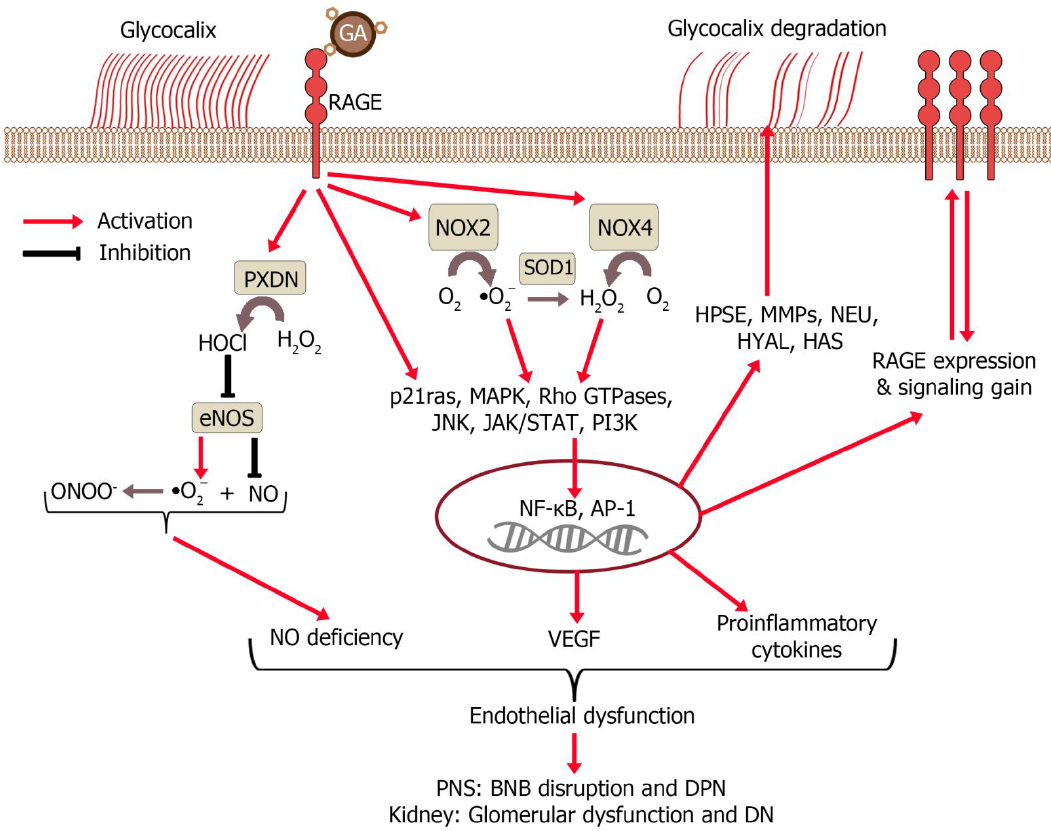
Figure 5. Interaction of glycated albumin with endothelial cells (EC). AP-1, activator protein 1; BNB, blood–nerve barrier; DN, diabetic nephropathy; DPN, diabetic peripheral neuropathy; eNOS, endothelial nitric oxide synthase; GA, glycated albumin; HAS, hyaluronic acid synthase; HPSE, heparanase; HYAL, hyaluronidases; JAK/STAT, Janus kinase signal transducer and activator of transcription; JNK, c-Jun N-terminal kinase; MAPK, mitogen-activated protein kinase; MMPs, matrix metalloproteinase; NEU, neu raminidase; NF- κB, nuclear factor kappa -light-chain-enhancer of activated B cells; NOX, NADPH oxidase; p21ras, products of the ras (rat sarcoma virus) gene family; Pho GTPase, Rho family of GTPases; PI3K, phosphoinositide 3-kinase; PNS, peripheral nervous system; PXDN, Peroxidasin; RAGE, receptor for advanced glycation endproducts; SOD, Superoxide dismutase; VEGF, vascular endothelial growth factor.